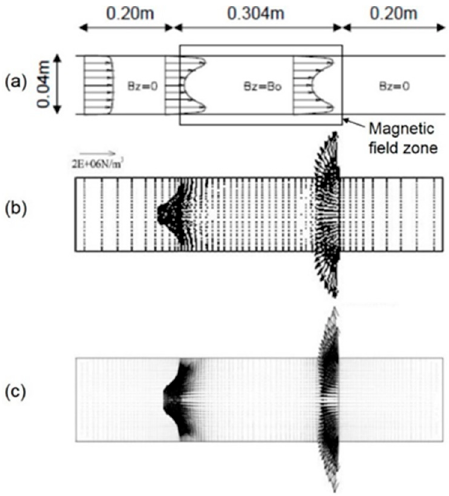
Figure 7. ( a ) Test channel domain of the magnetohydrodynamics (MHD) models and Lorentz force vectors calculated ( b ) with potential method [99] and ( c ) with magnetic induction method [61].